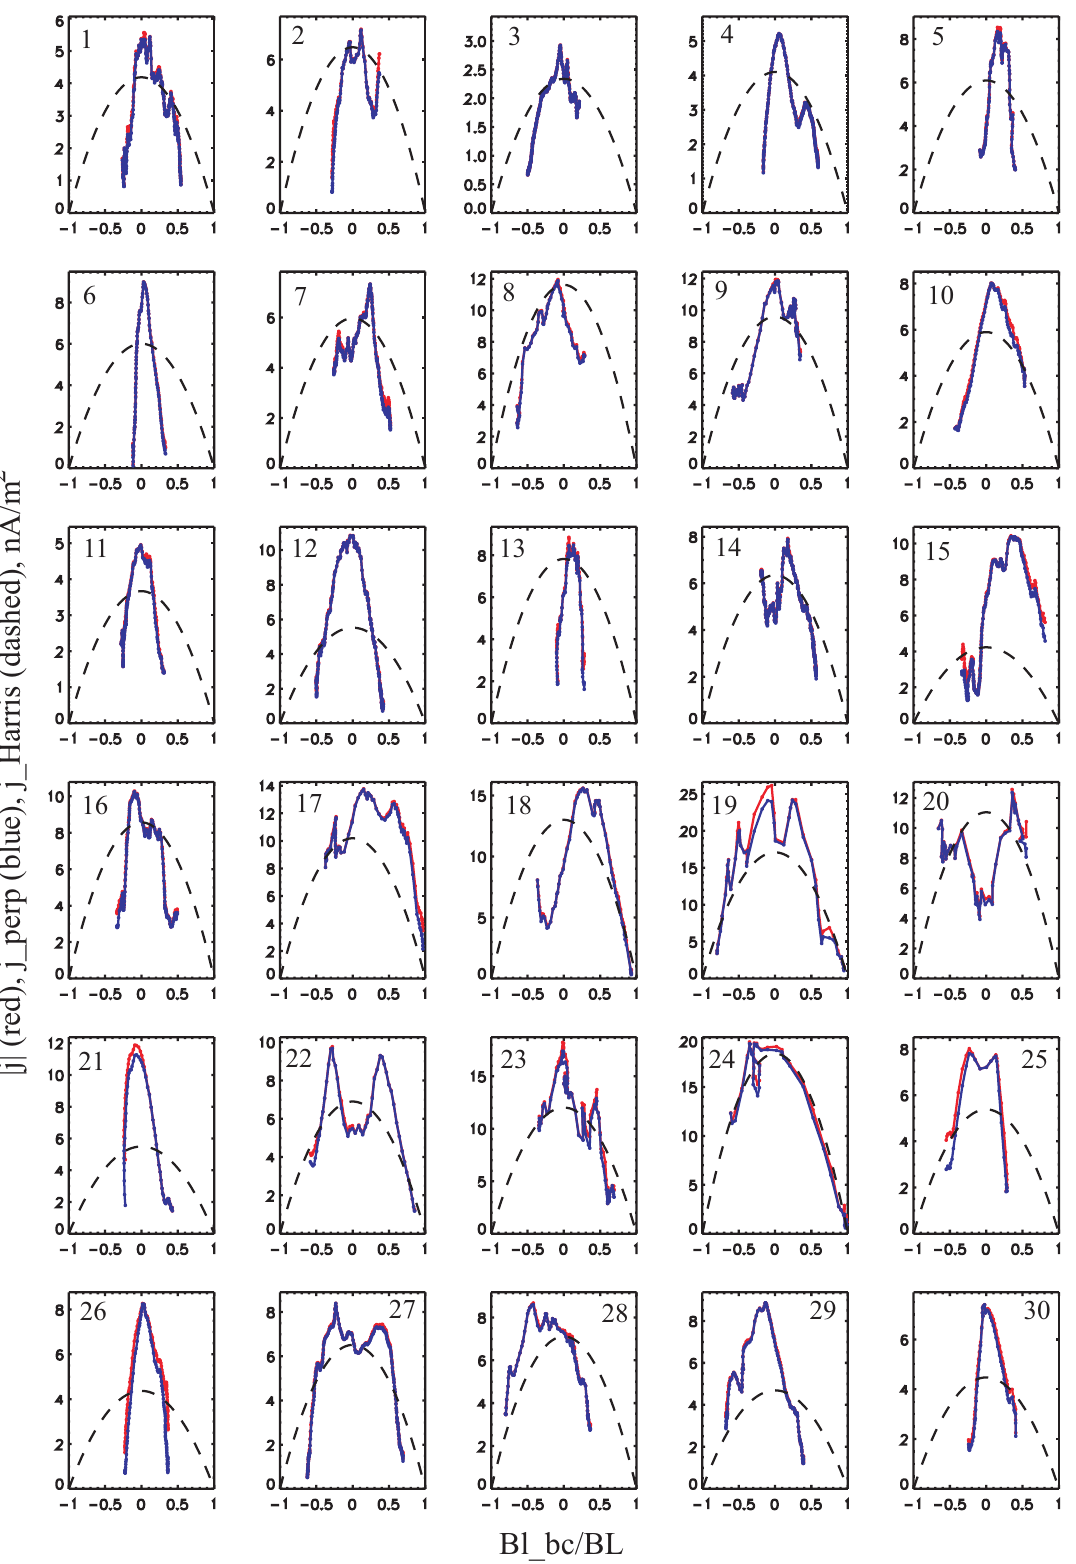
q j 2 m + j 2 n (red) versus main